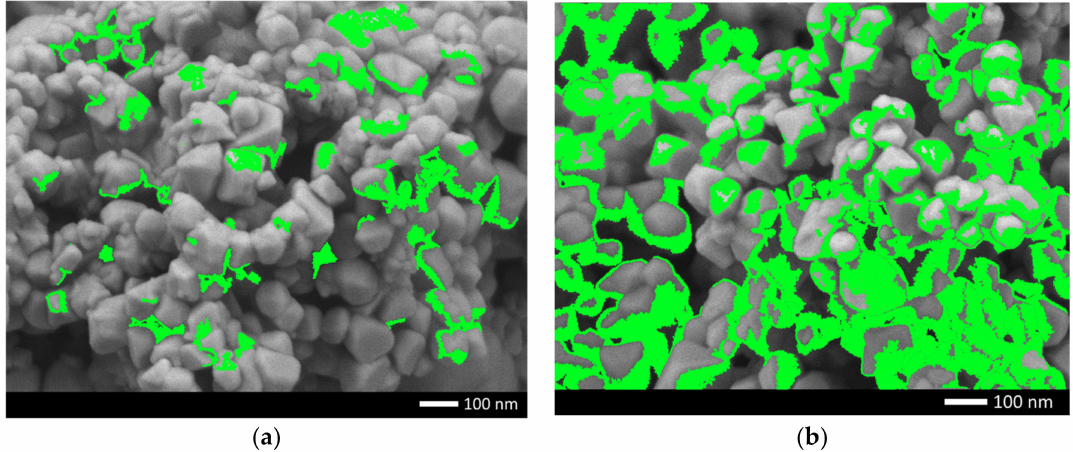
Figure 2. Mapping results reflecting nickel distributions in the structure of ceramics after doping: ( a ) 0.10 mol; ( b ) 0.25 mol. (Green reflects the distribution of nickel in the structure of